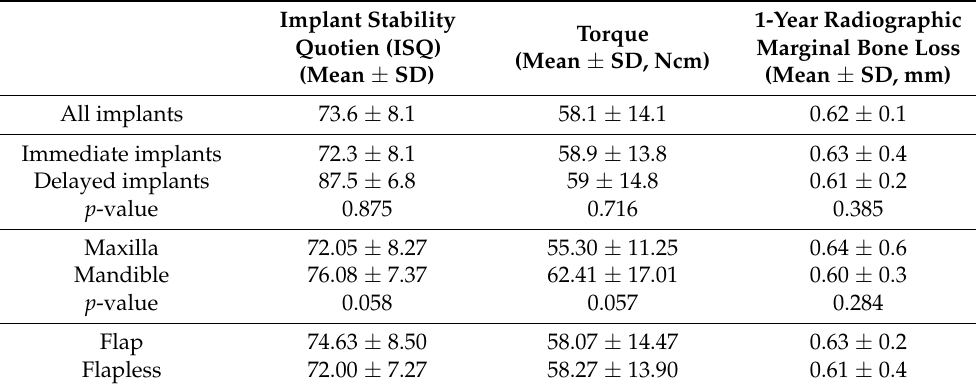
Table 1. Main results of primary stability values of investigated